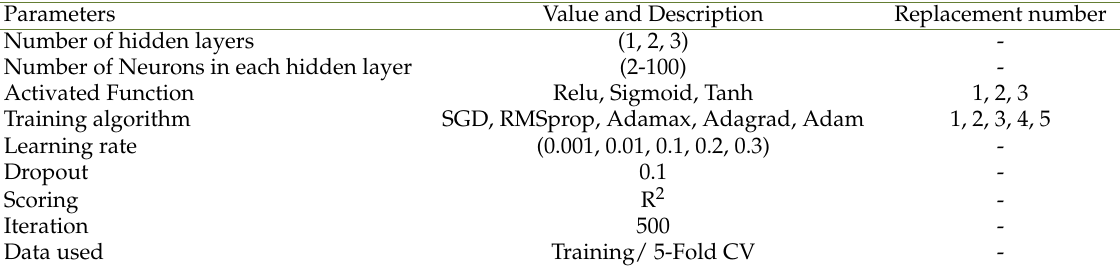
Table 3. Initialization hyper parameters of DNN model